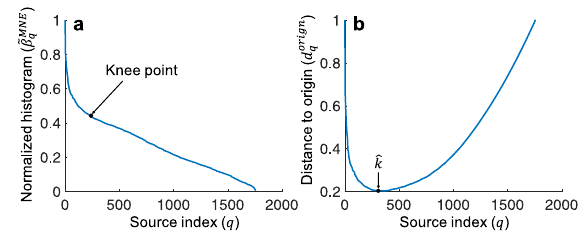
Fig. 6 Estimation of the size of the region of silence ( k ) in the modi fi ed MNE algorithm based on the knee point detection. a ~ β MNE q is the normalized and sorted histogram of sources in a descending order, which captures the frequency of a source to being among the ^ k sources with the minimum power over time. In this curve, a Knee point is de fi ned as the point with maximum curvature, i.e., the point where the curve